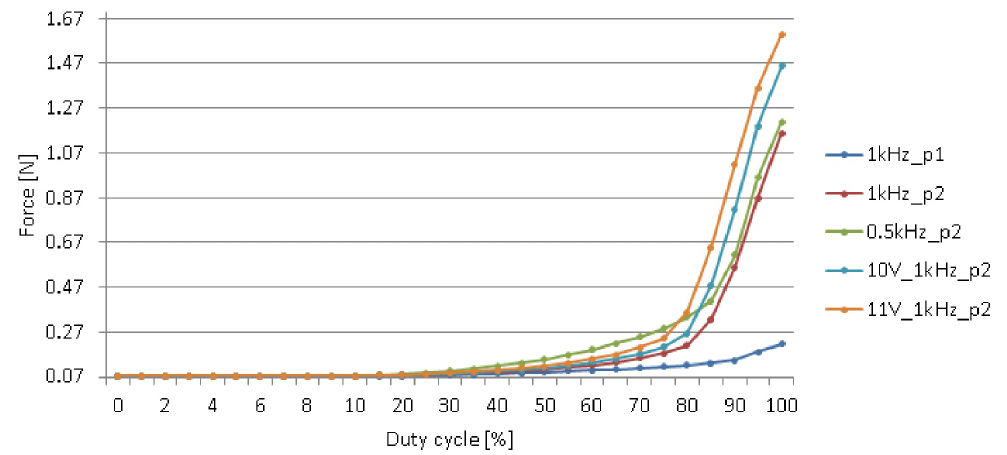
Figure 8. Comparison of the influence of solenoids parameters on generated force.